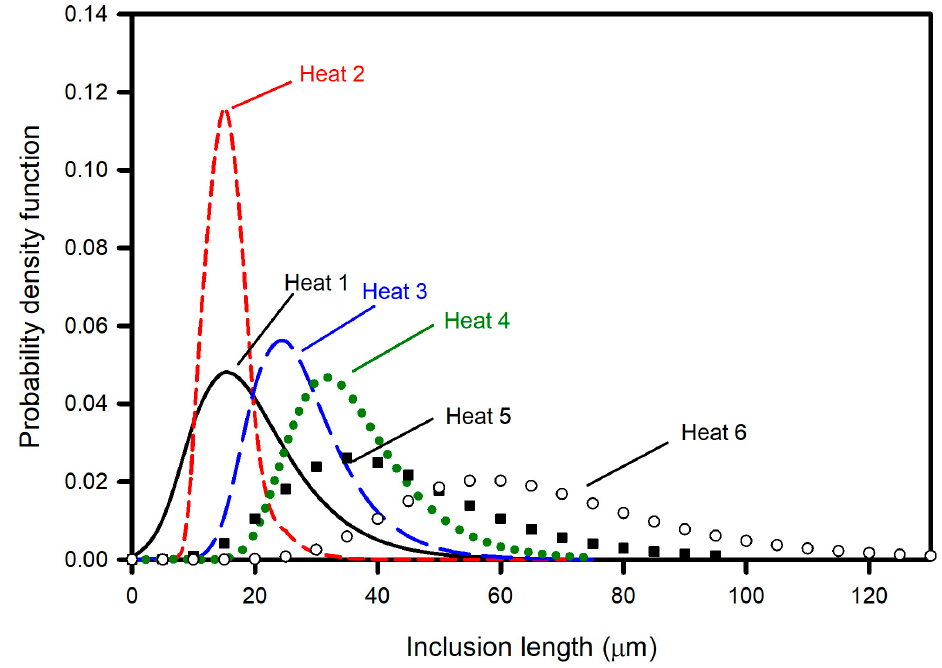
Figure 12. Probability density function for